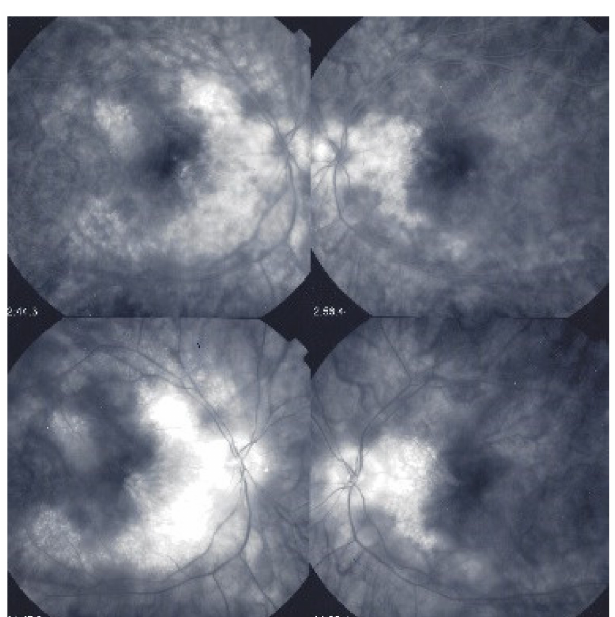
Figure 43. Foveal sparing of diffuse retinal edema. This patient was followed for more than seven years for “neuroretinitis”, without treatment. There is massive retinal oedema that also involves the posterior pole, yet the fovea remains relatively spared, which explains the patient’s preserved visual acuity, while visual fields were severely impaired (Figure